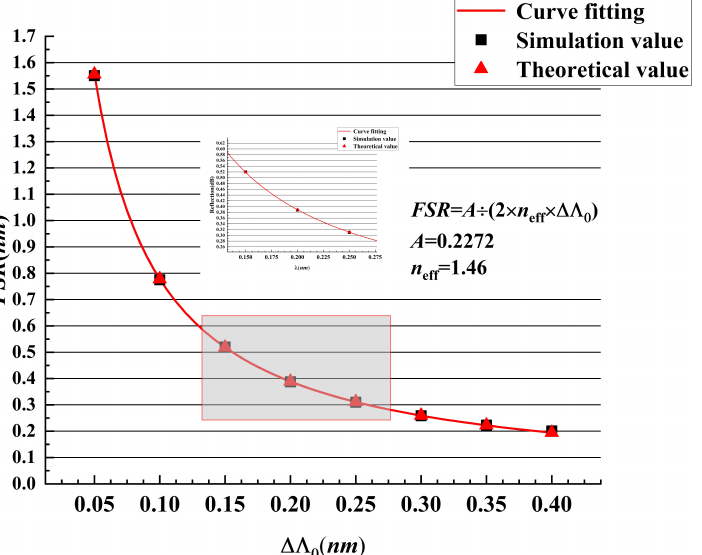
Figure 9. Trend diagram and curve for the FSR variation with the initial period difference for a 2D chirped fiber